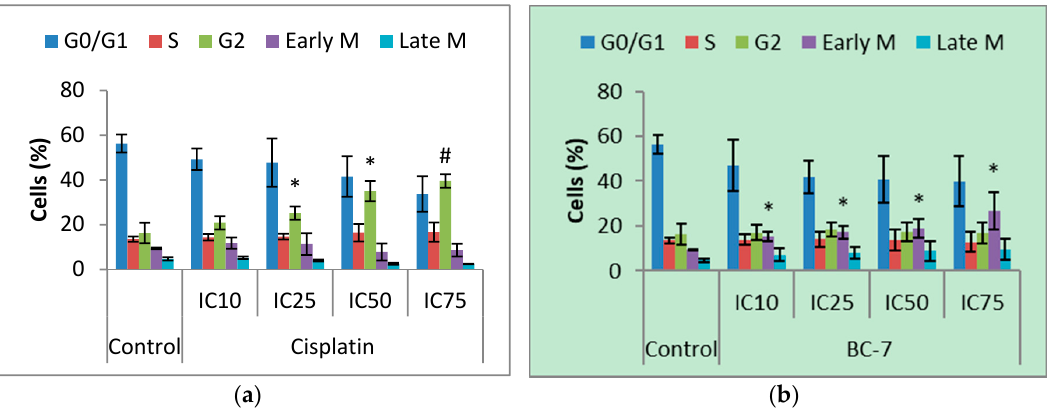
Figure 1. Cell cycle analysis of HeLa cells after 24 h treatment with ( a ) cisplatin and ( b ) BC-7. Cell cycle analysis was determined by the NucRed ™ Live 647 staining method. Control treatment refers to untreated control. Results displayed as percentage of cells detected in each phase. Error bars indicate SD of three individual experiments, each performed in quadruplicate ( n = 3). Significance was determined using the two-tailed student t-test: * p < 0.05 and # p < 0.005 compared to untreated control.